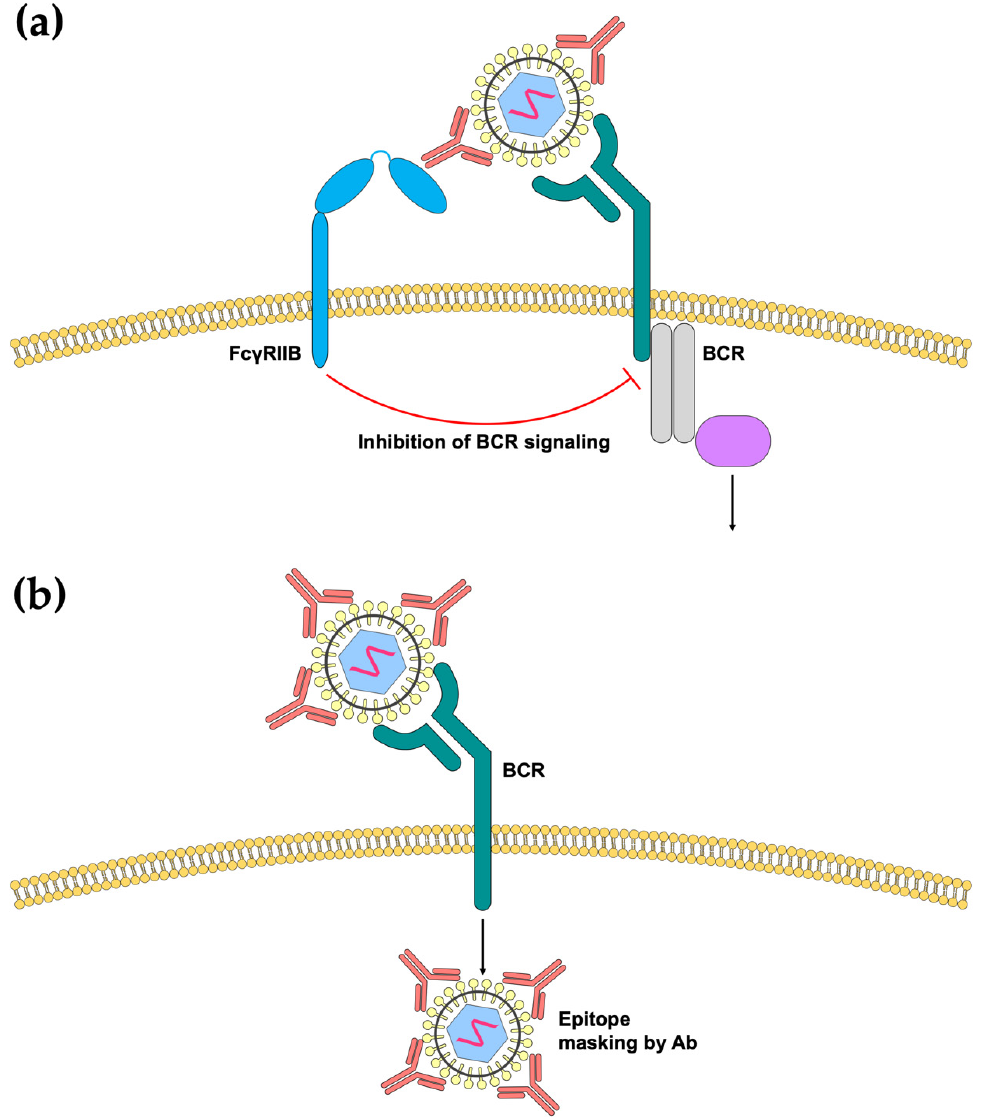
Figure 2. E ff ects of antibody binding on B-cell activation. ( a ) Formation of viral immune complexes may result in cross-linking and activation of the inhibitory Fc γ RIIB, which in turn inhibits downstream BCR signaling. ( b ) Antibody binding may prevent the exposure of epitopes normally recognized by B-cells in a phenomenon known as “epitope masking”, thereby preventing B-cell